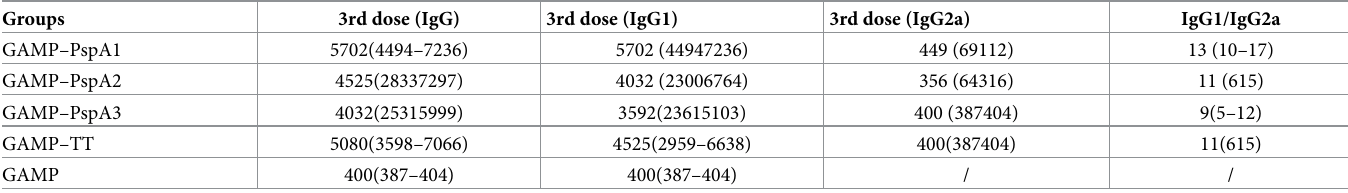
Note: The results were expressed as the reciprocal of geometric mean titer (GMT). “/” indicates that no antibody was